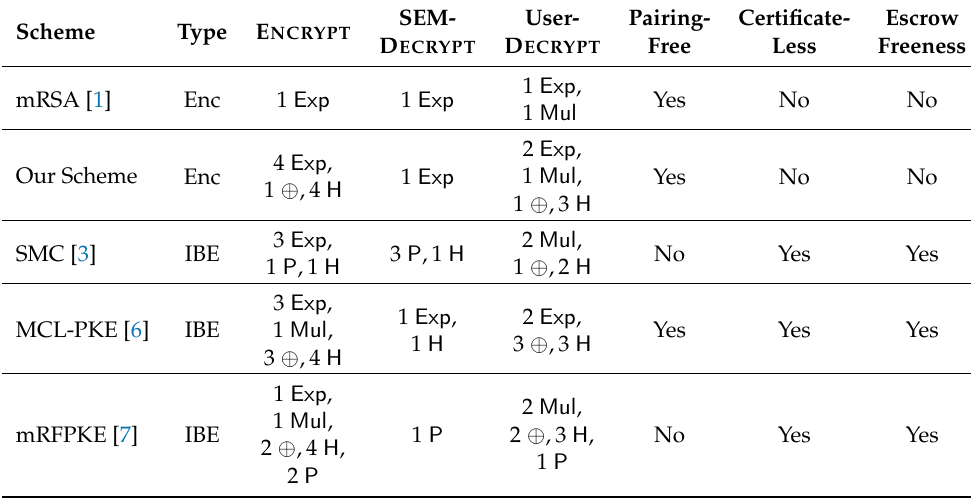
Table 2. Computation Performance of Security Mediated Encryption Schemes.